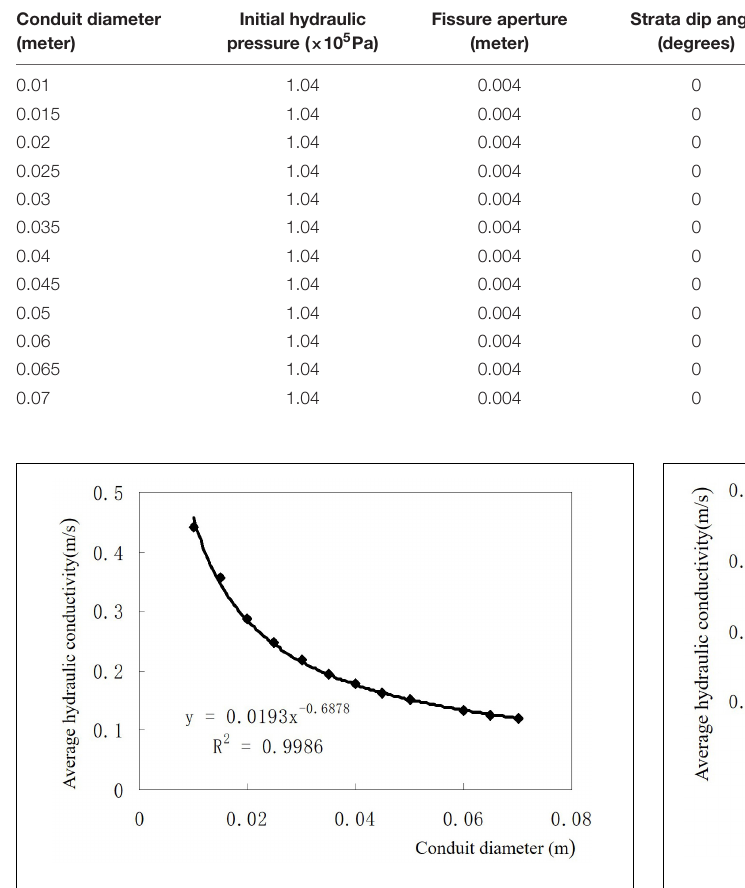
FIGURE 8 | The relationship diagram between the average hydraulic conductivity and fissure aperture.